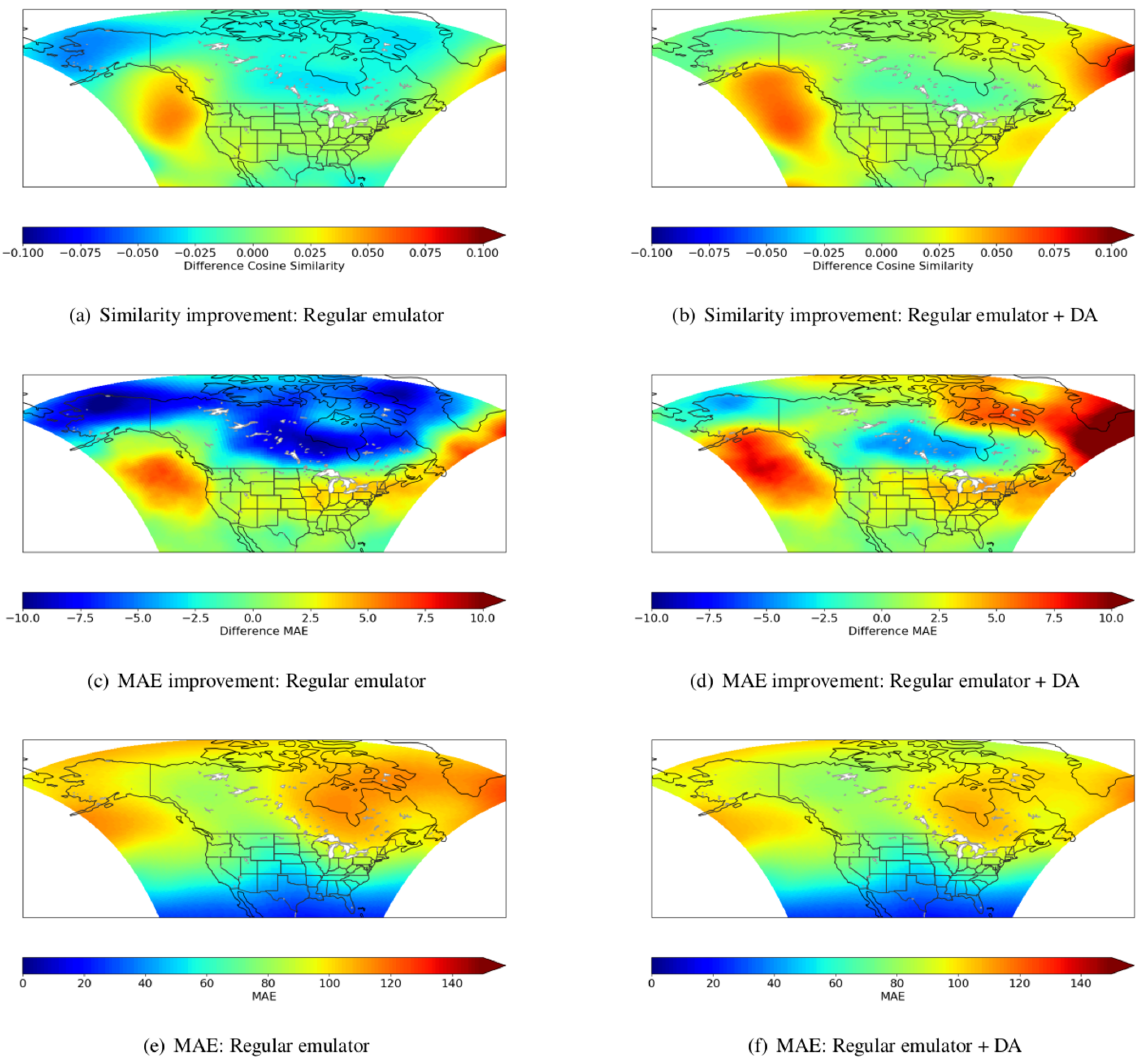
Figure 3. Improvements over climatology for the regular emulator (a, c, e) and DA-corrected emulator (b, d, f) when using the best set of hyperparameters as determined on validation data. Here cosine similarity captures an agreement in the trend between forecast and truth, and MAE refers to the mean absolute error between the same. These contours are averaged over all